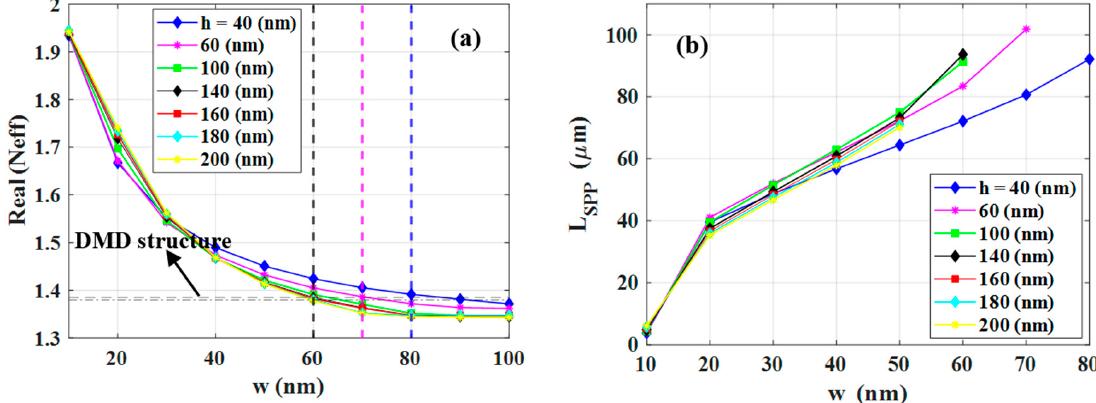
Figure 7. ( a ) The real part of the effective mode index ( N ef f ) of the plasmonic slot waveguide (PSWG) as a function of the slot width w for different slot heights h . The horizontal dashed line shows the effective mode index of the silica-gold-air DMD structure, while the dash-dotted line below indicates the refractive index of the silica substrate. Three vertical black, magenta and blue dashed lines represent the cut-off slot widths for h = 40, 60, as well as 100 and 140 (featuring the same cut-off). ( b ) The propagation length of the fundamental guided mode of the PSWG as a function of the slot width.